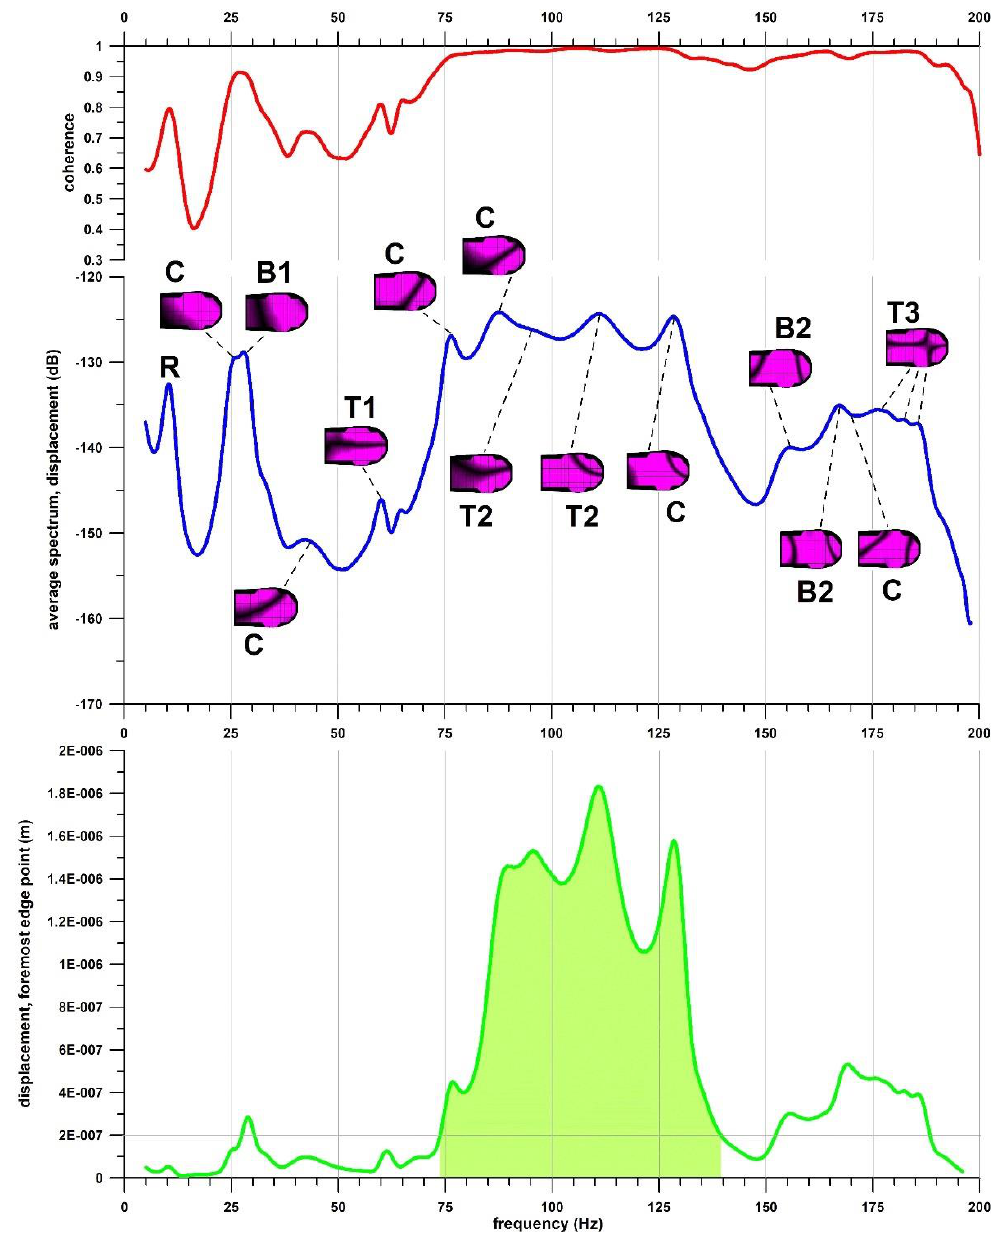
Figure 7. Shovel A tilted by 50°; coherence (red), average spectrum of the shovel’s displacement (blue; in dB), and displacement of the frontmost edge point (green; in m) against the frequency; the purple insets show the node lines of each mode; R = rigid body motion of the board plus test rig about the edge line; T = torsional mode, B = bending mode, C = combined (torsional and bending) mode; 1, 2, 3 = first, second, and third mode; the green area under the edge point displacement curve is used for calculating the edge mobility measure (magnitude of the displacement continuously exceeding 0.2 mm).